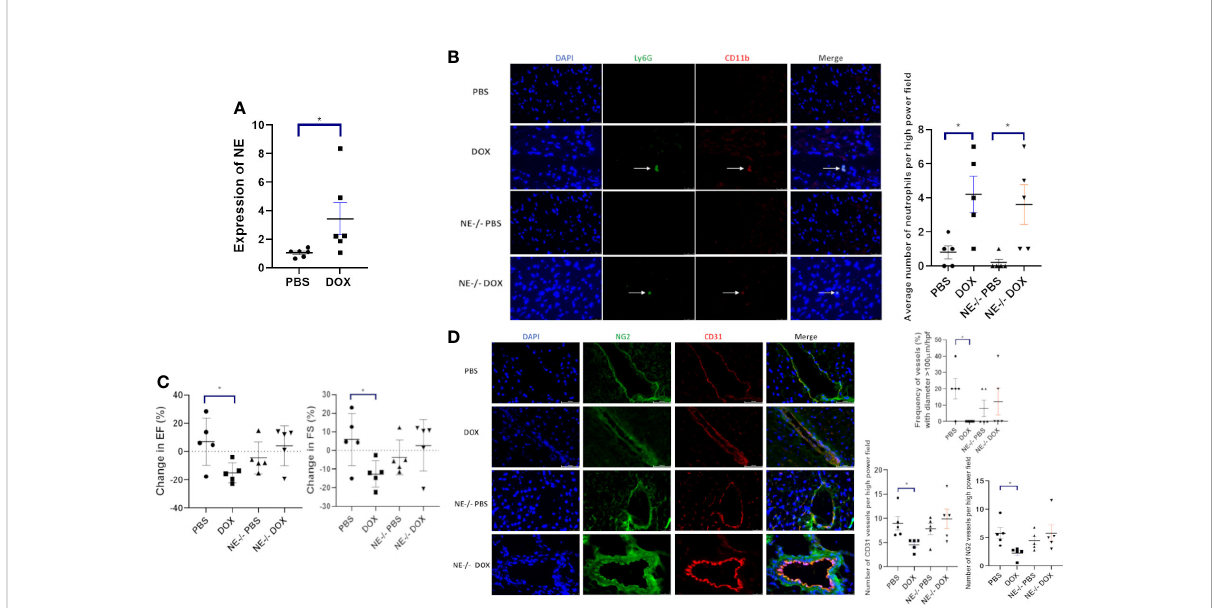
FIGURE 4 Effect of neutrophil elastase knockout (NE -/- ) on heart function 24 h after therapy. (A) NE as measured by quantitative PCR in hearts of wild-type and NE -/- mice 24 h after treatment with control phosphate-buffered saline(PBS) or doxorubicin(DOX); (B) Representative images of neutrophils (CD11b + Ly6G + ) 24 h after therapy; (C) Ejection Fraction (EF) and fractional shortening (FS) were quanti fi ed by echocardiography 24 h after therapy; (D) Effect of NE knockout on cardiac vessel morphology 24 h after therapy. Representative images, the number of NG2 + and CD31 + vessels, and the frequency (%) of vessels > 100µm/hpf 24h after therapy. Data are presented as mean ± SEM, n = 5 each, * p < 0.05, one-way ANOVA analysis with Tukey comparison was used to compare the